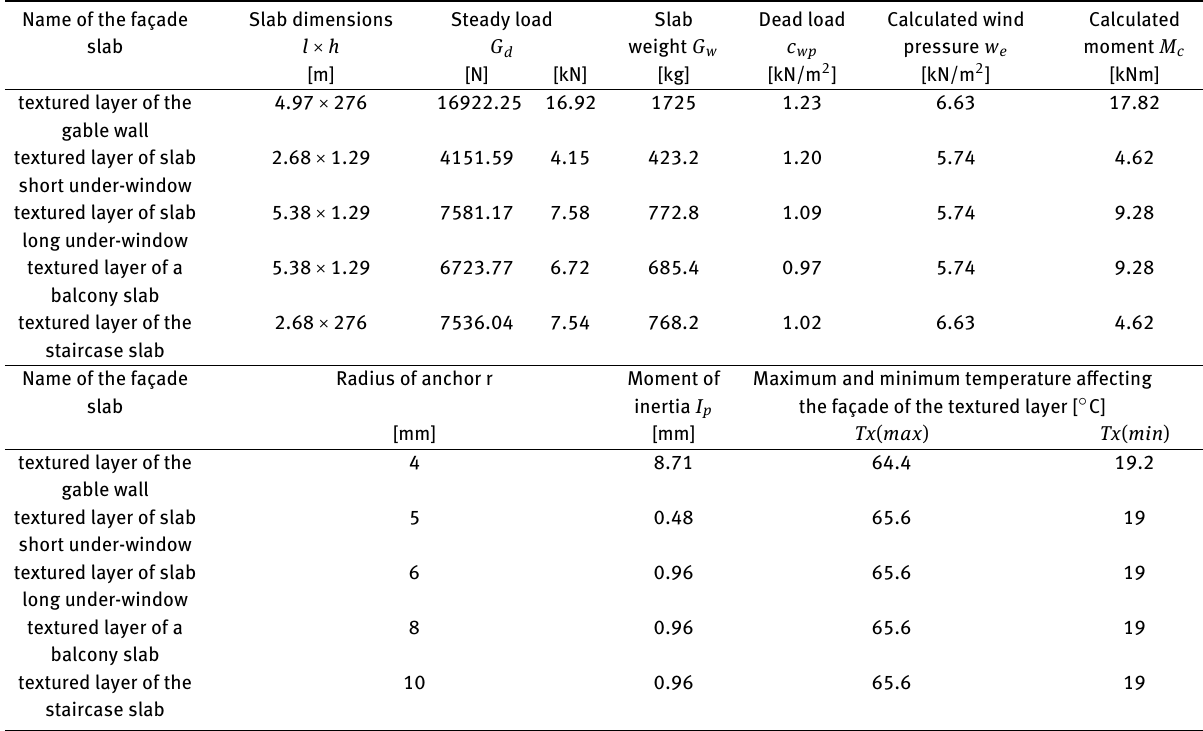
Table 1: The juxtaposition of input